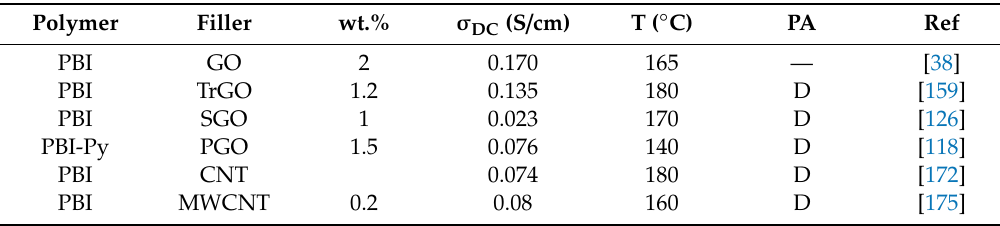
Table 9. Composite membranes of polybenzimidazole derivates with GO derivates. MWCNT, multiwalled carbon nanotube. GO, graphene oxide; PGO, phosphonated GO; SGO, sulfonated GO; TrGO, GO bearing triazole